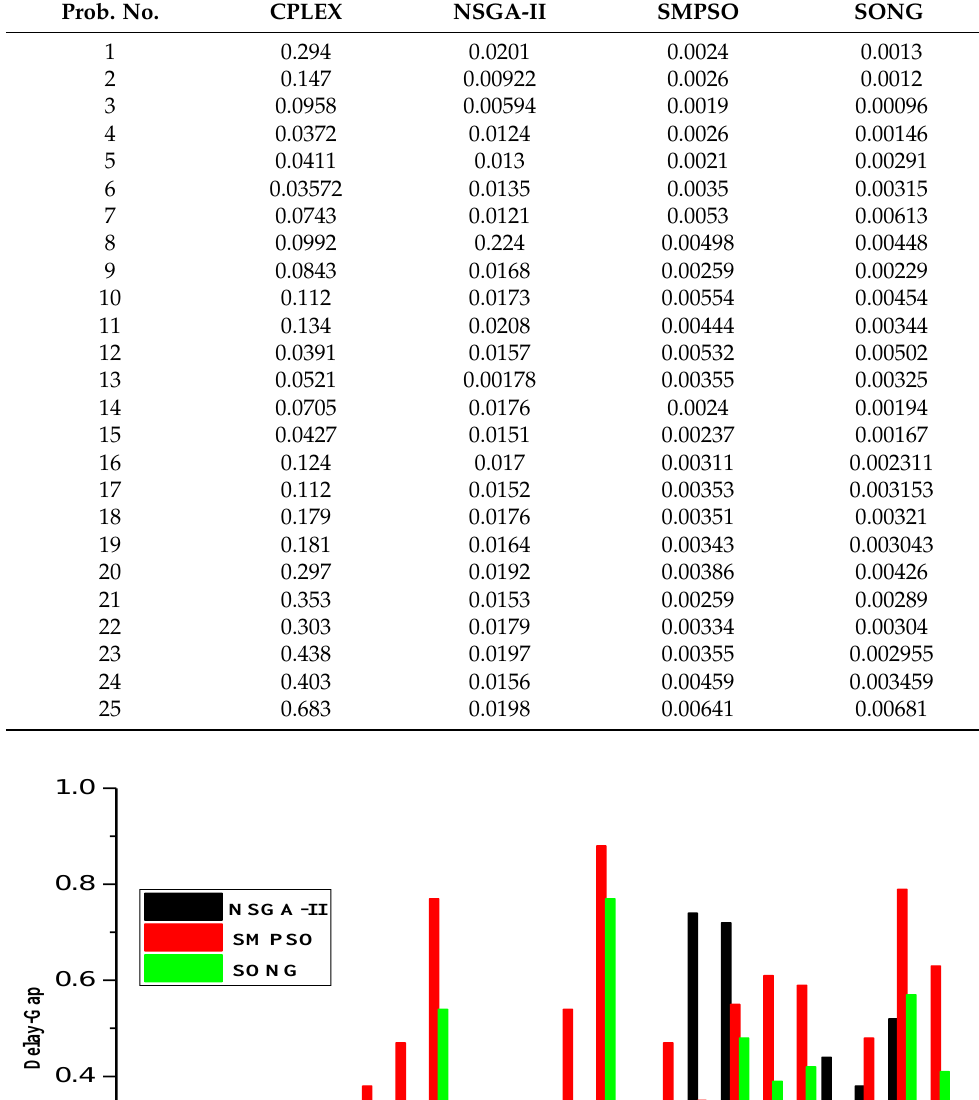
Table 6. Comparison of IGD values.